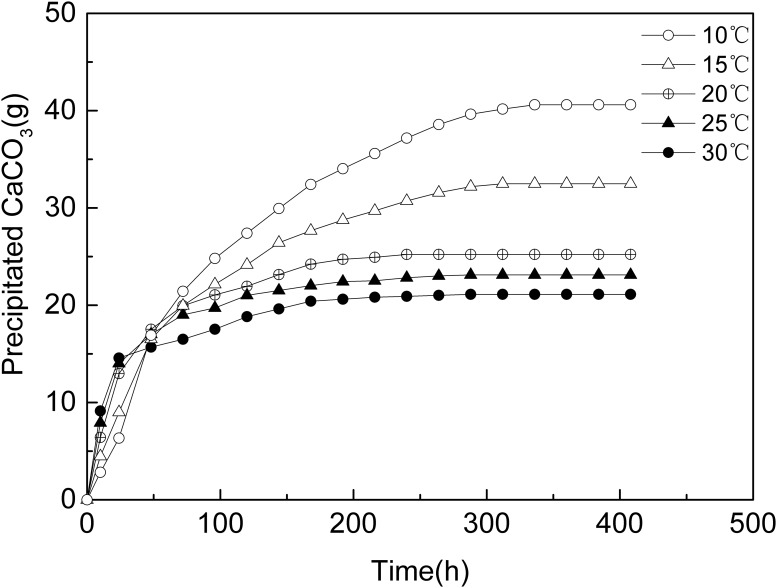
Amount of CaCO3 precipitation vs. time.